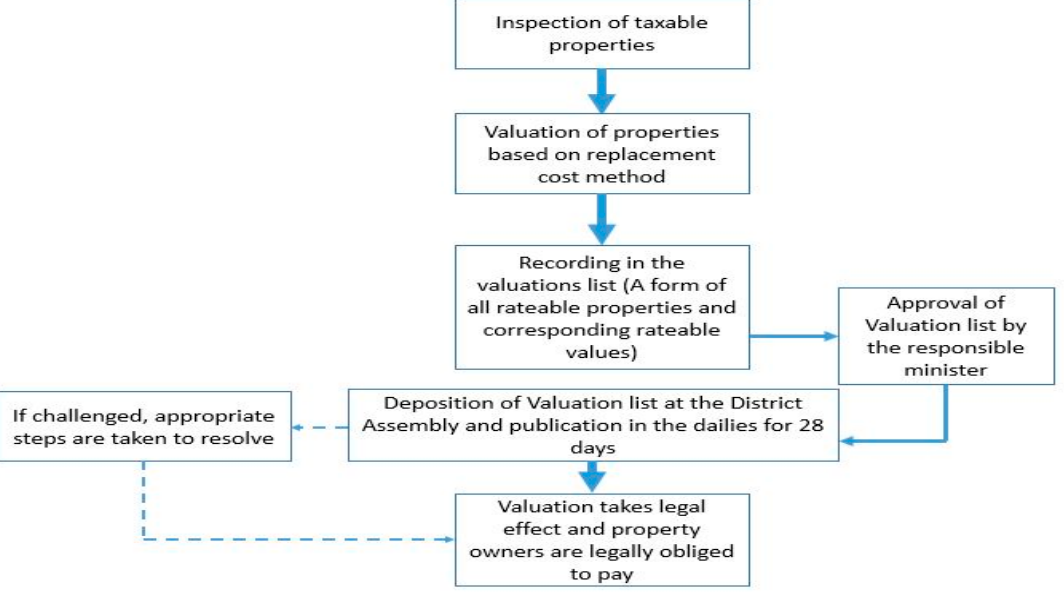
Figure 5. Property taxation process. Based on [62,63].